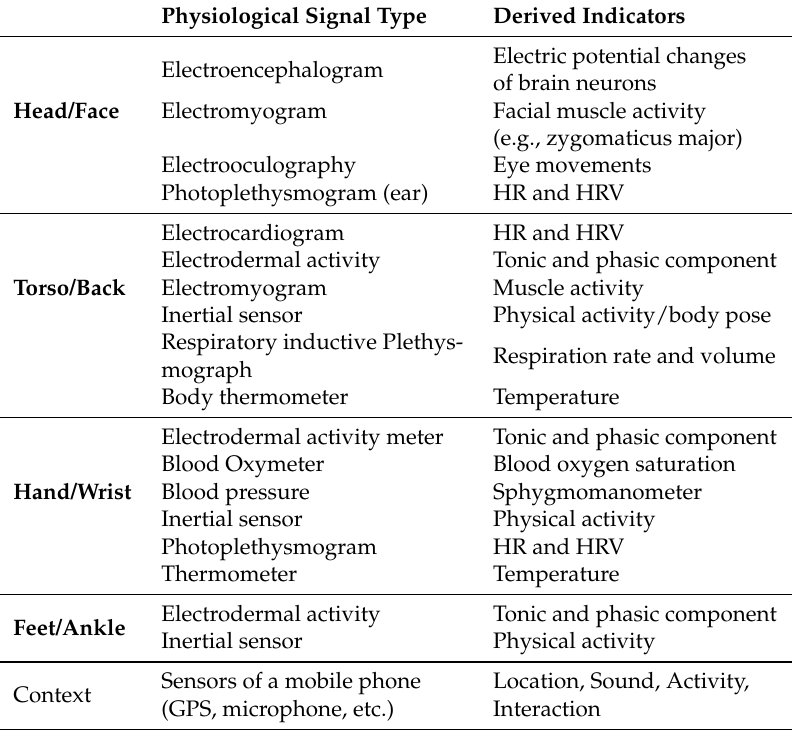
Table 3. Sensor modalities and derived indicators used in the wearable-based AR. Abbreviations: heart rate (HR), heart rate variability